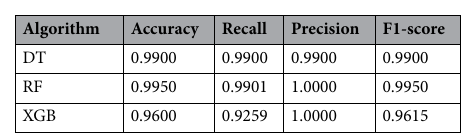
Table 5. Performance evaluation on under sampled